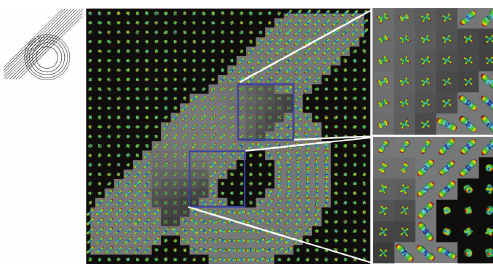
Figure 3: Synthetic dataset experiment. Left: fiber bundle layout. Centre: Pr (7) 4,4 . Right: zoom into the regions with crossings—top: the changing angle between the fiber bundles is detected and bottom: three types of voxels—isotropic, single fiber, and crossing